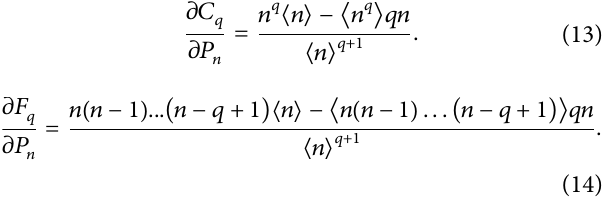
collisions recorded by the CMS experiment 𝑝𝑝